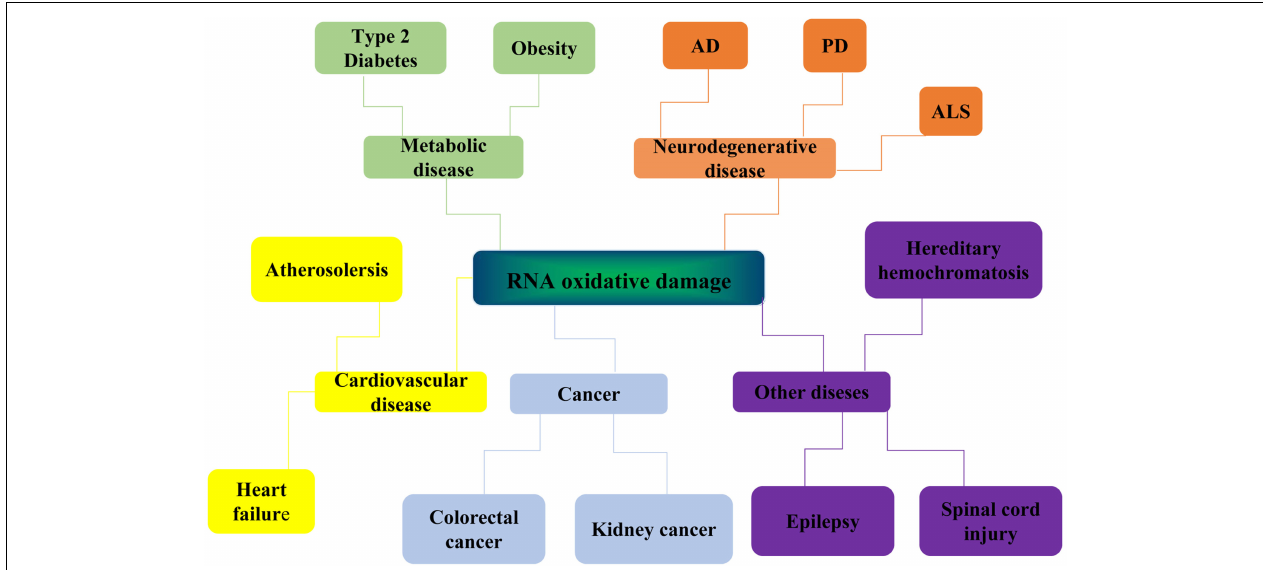
FIGURE 2 | Diseases related to RNA oxidative damage. RNA oxidative damage is associated with the development of many diseases. It is mainly related to the occurrence and development of four kinds of diseases: neurodegenerative diseases, metabolic diseases, cardiovascular diseases, and cancer. Neurodegenerative diseases include Alzheimer’s disease (Alzheimer diseases, AD), Parkinson’s disease (PD) and Amyotrophic lateral sclerosis (ALS). Metabolic diseases include type 2 diabetes and obesity. Cardiovascular diseases include atherosclerosis and heart failure. Cancer include colorectal cancer and kidney cancer. It is also associated with hereditary hemochromatosis, spinal cord injury, epilepsy, and other